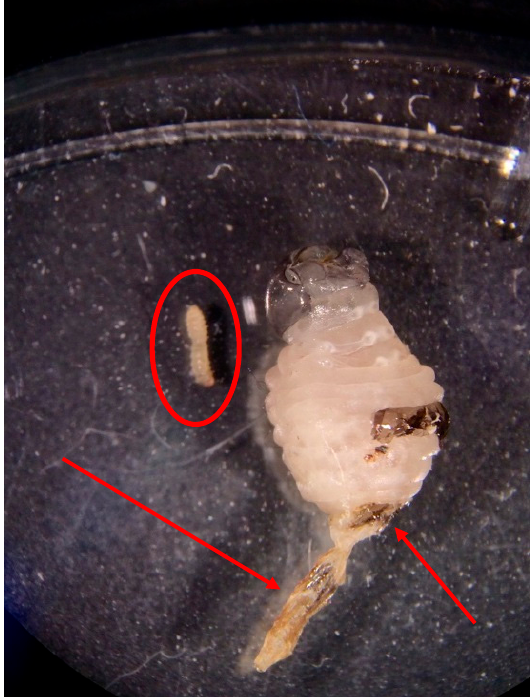
Figure 3. A live late instar P. dorsalis larva with arrows showing damage from feeding by C. iphitalis larva (circled).